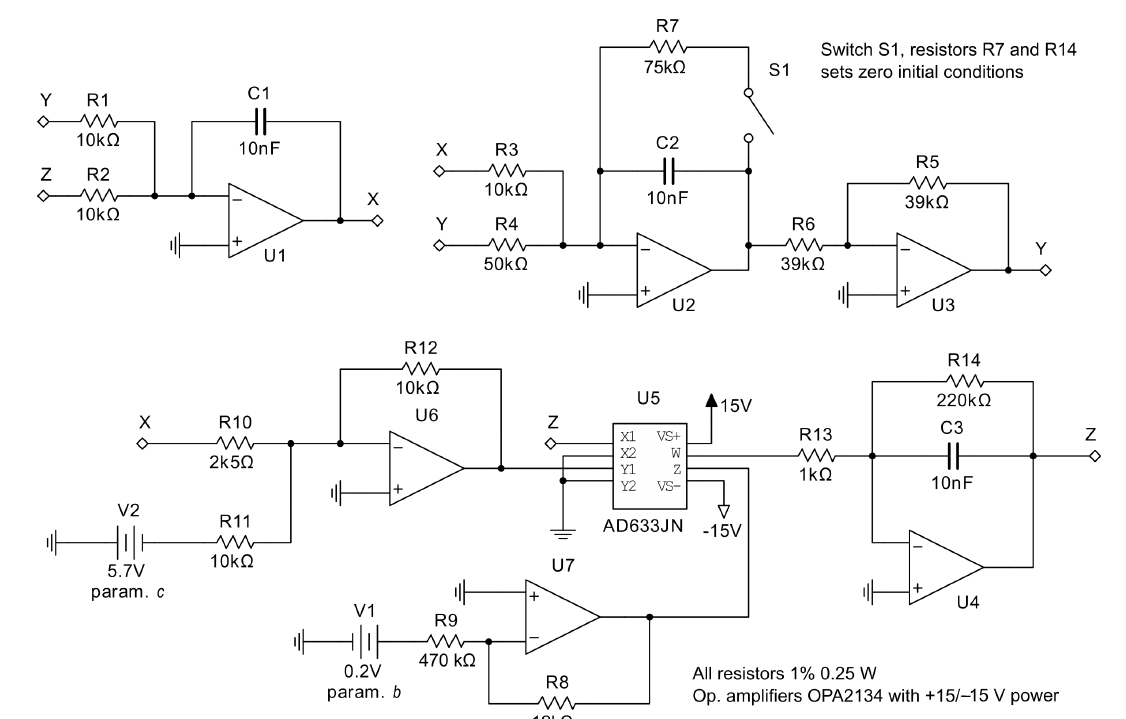
Figure 6. Circuit implementing the Rössler chaotic system with parameters b and c defined as input voltages. Circuit state variables X , Y and Z presented as voltages are down-scaled by M = 4 compared to their numerical